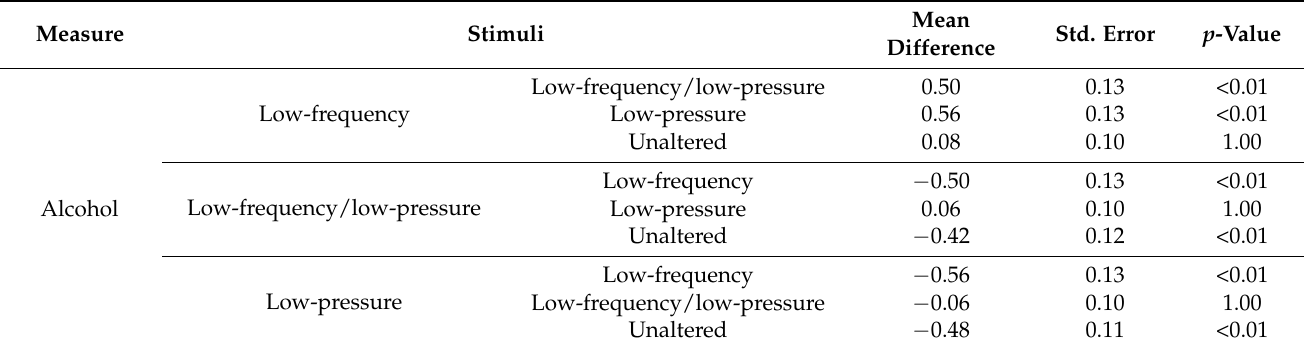
Table A3. Summary of the results of the pairwise comparisons of Experiment 1 within-participants condition (sound manipulation) for sensory